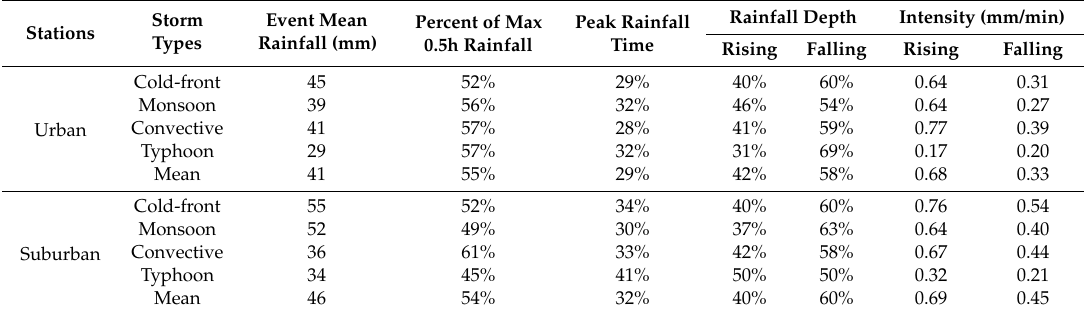
Table 2. Statistics of storm events for the one minute-interval data during 2008–2012 (Sites 1–2) and 2014–2017 (Sites 3–6). The peak rainfall time is determined using the maximum five-minute rainfall accumulation. The rainfall time is normalized using the total rainfall duration.